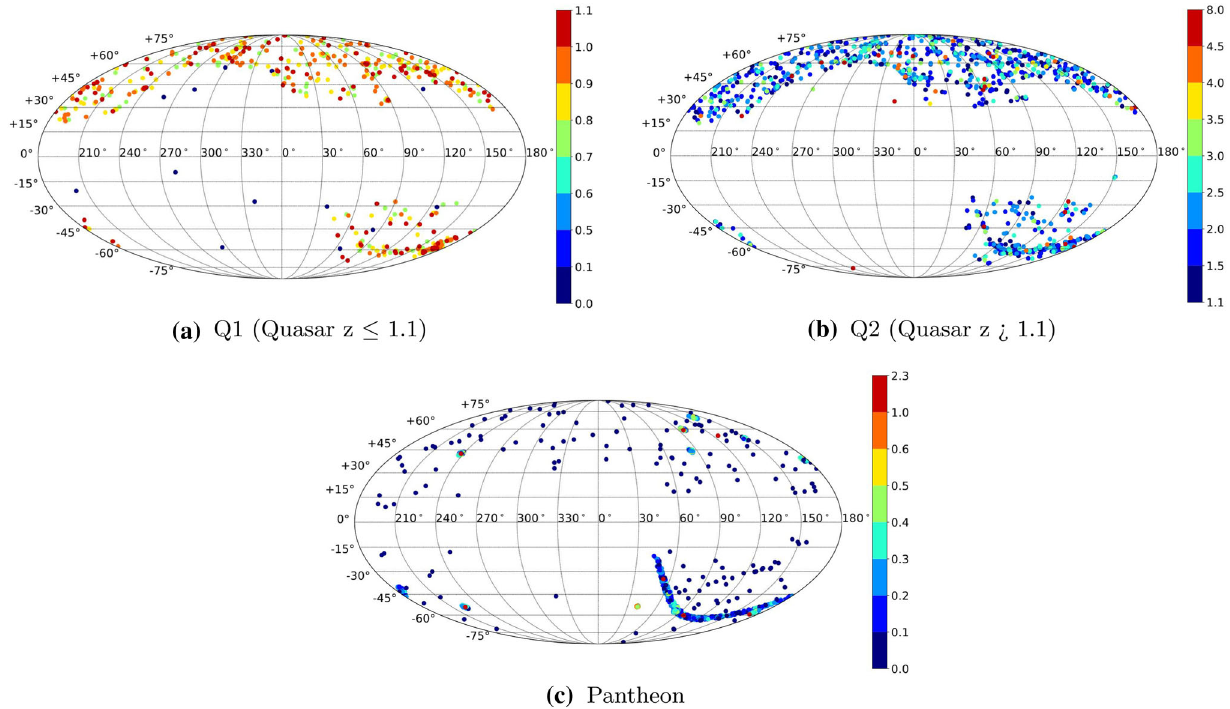
Fig. 2 The distribution of subsets Q1, Q2, and Pantheon sample in the galactic coordinate system. The pseudo-colors represent the redshift of quasars or SNe